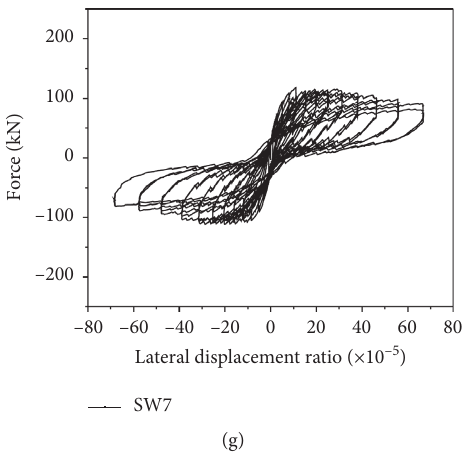
Figure 6: Shear wall hysteresis curves. (a) SW1 hysteresis curves. (b) SW2 hysteresis curves. (c) SW3 hysteresis curves. (d) SW4 hysteresis curves. (e) SW5 hysteresis curves. (f) SW6 hysteresis curves. (g) SW7 hysteresis curves. Table 4: Failure grade of reinforced concrete shear wall members based on skeleton curve.